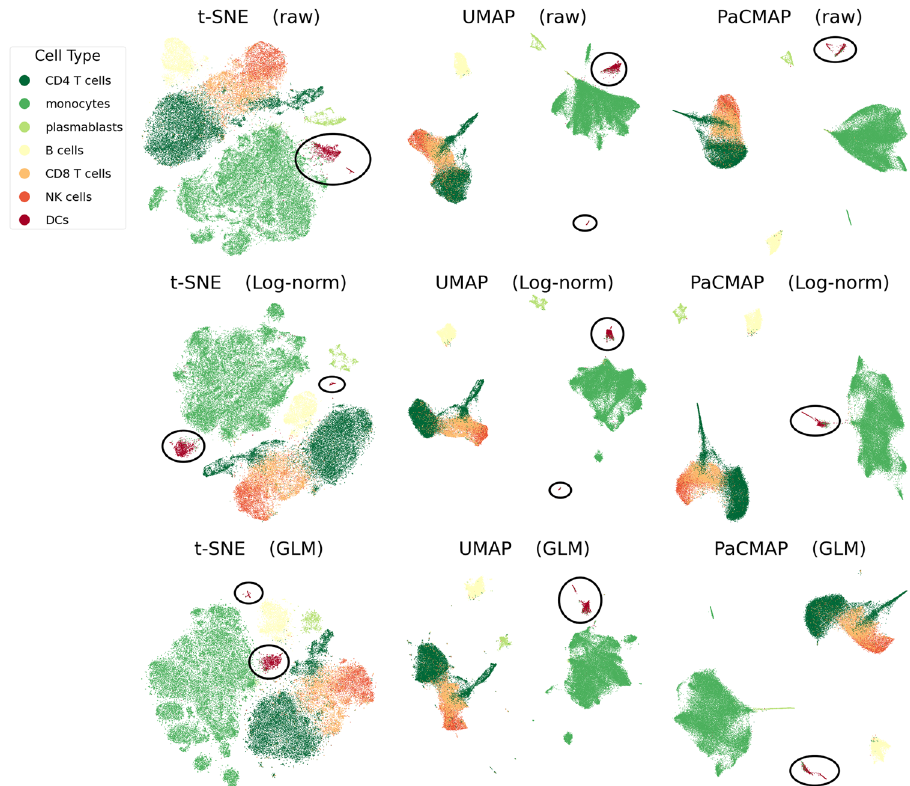
Fig. 7 Sensitivity of DR results to pre-processing methods on the Stuart et al. 30 dataset. This dataset was pre-processed either with either no PCA and no log transformation (raw), log-normalization (Log-norm) or by GLM-PCA. The distance relationship between two of the DCs clusters (mDCs and pDCs) varies dramatically in t-SNE and UMAP when changing pre-processing methods. There are unfavorable outliers and tiny clusters in t-SNE and UMAP results with GLM-PCA pre-processing. For raw data and log-normalized data, the number of dimensions from PCA is 70, for GLM-PCA pre-processed data, the number of PCA dimensions is 50. GLM-PCA is computationally infeasible to run for more than 50 PCA dimensions.